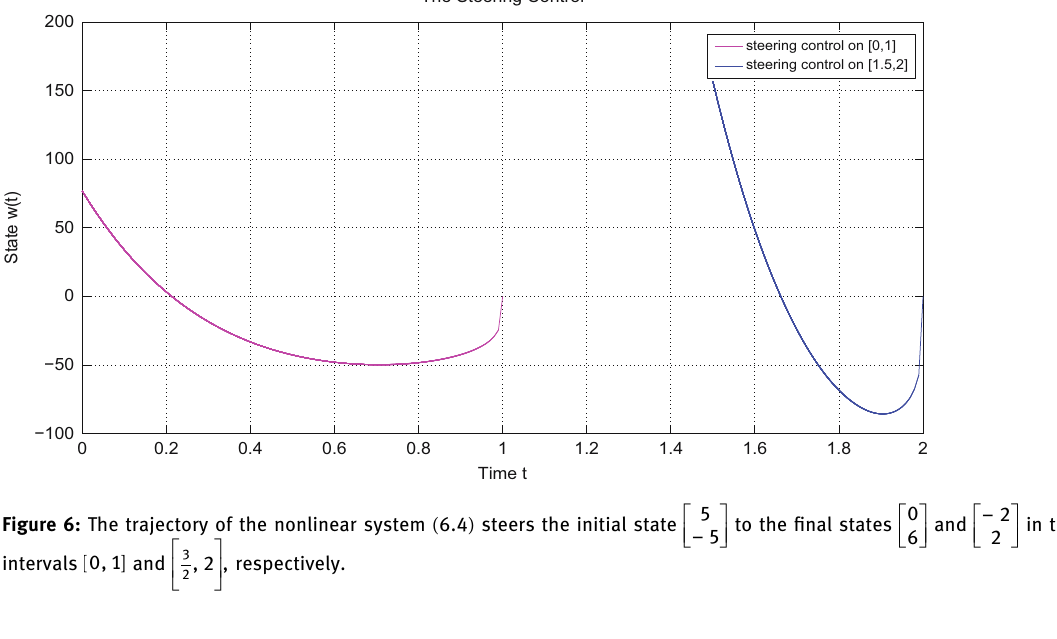
0 − 2     and in the     2 6